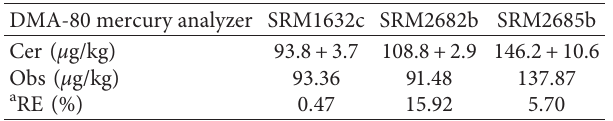
50mg sample (HNO 3 +HF +au)